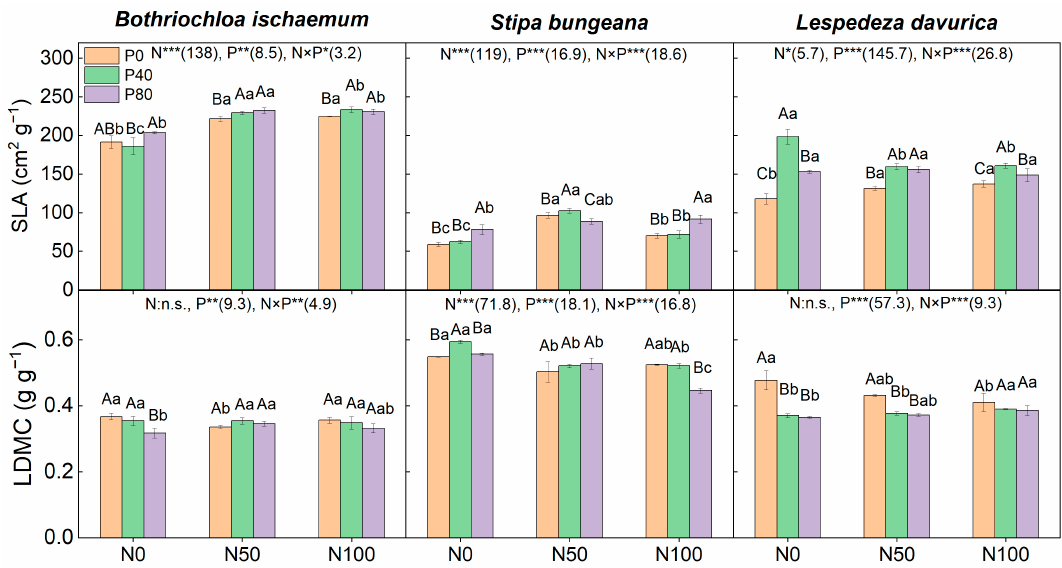
Figure 6. Specific leaf area (SLA) and leaf dry matter content (LDMC) of the three species under different N and P addition treatments. Different capital letters above the column indicate significant differences among P additions under each N addition rate, while different small letters indicate significant differences among N additions under each P addition rate. Numbers in parentheses are F -values, while ‘*’, ‘**’, and ‘***’ indicate p ≤ 0.05, p ≤ 0.01, and p ≤ 0.001, respectively. ‘n.s.’ indicates no significant difference.